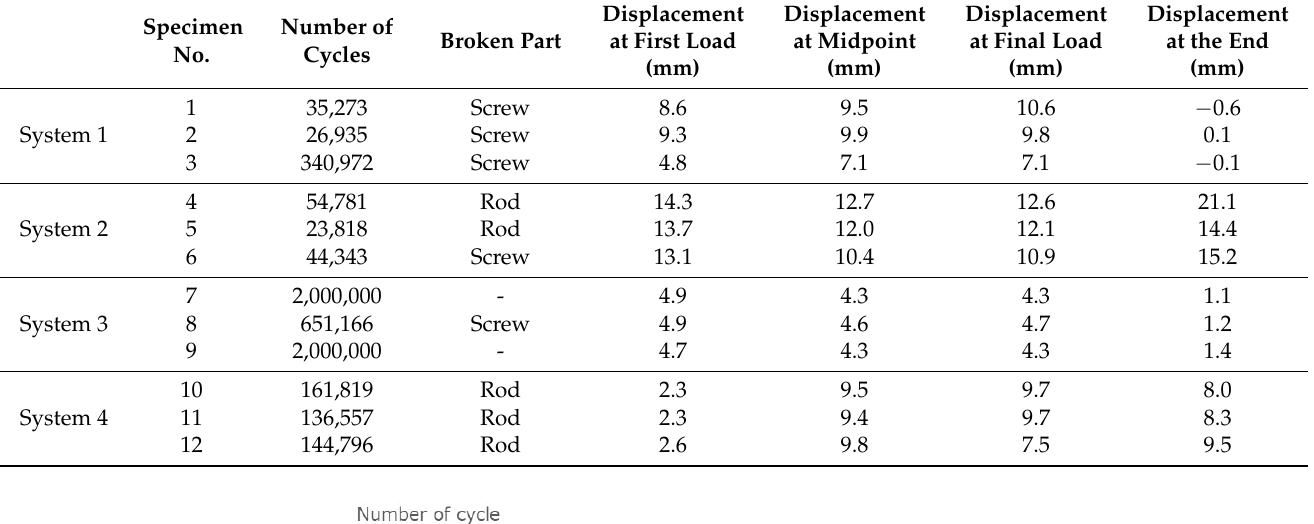
Table 2. Fatigue test results.